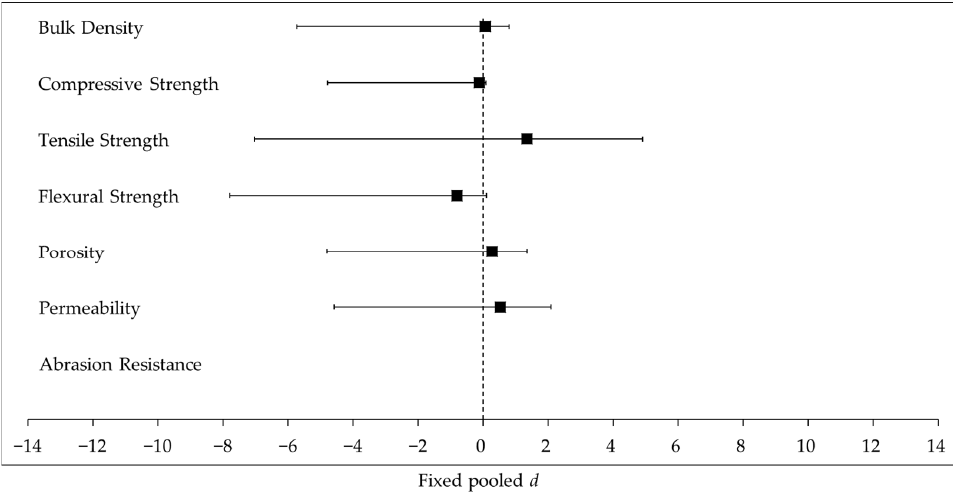
Figure 8. Overall performance of PC with different aggregate replacements based on fixed effect.